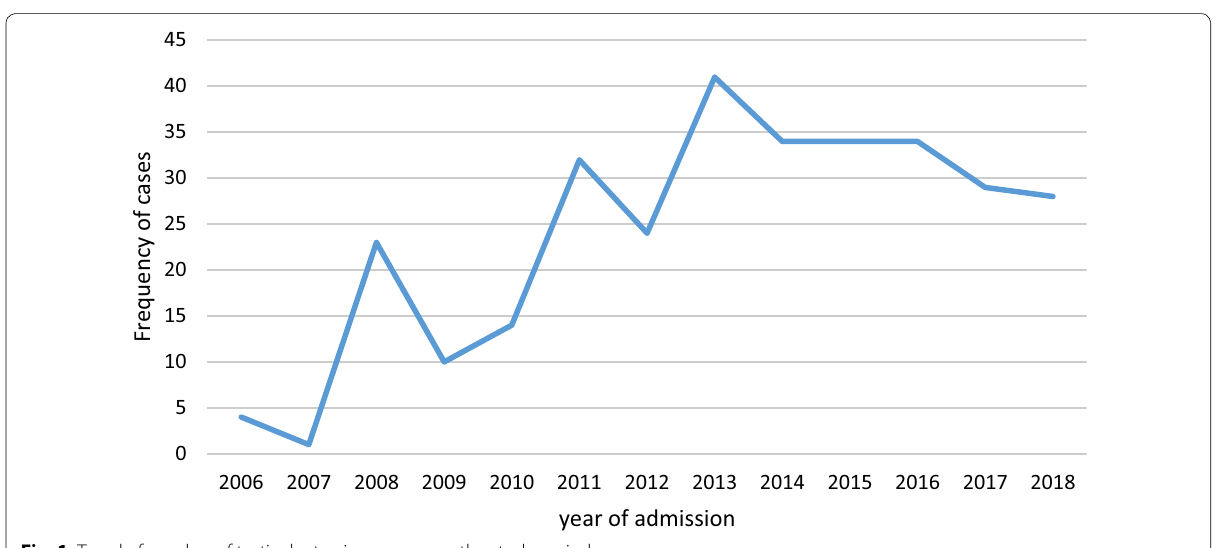
Fig. 1 Trend of number of testicular torsion cases over the study